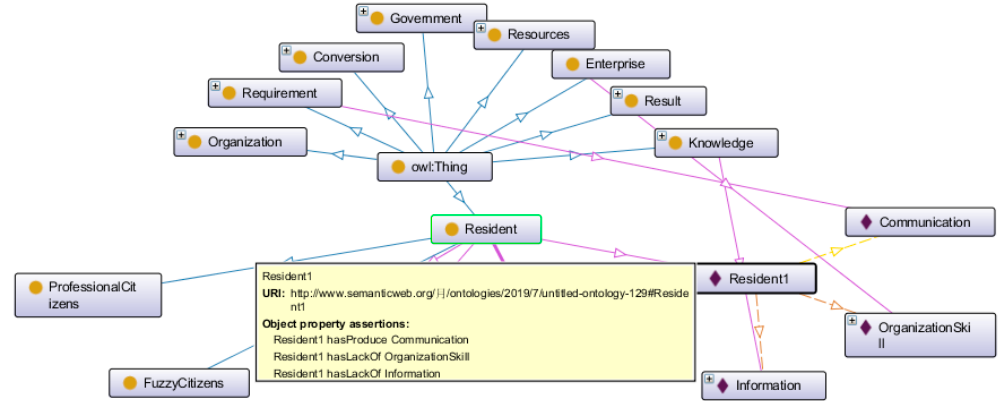
Figure 9. The ontoGraf of Resident1 in Protégé.